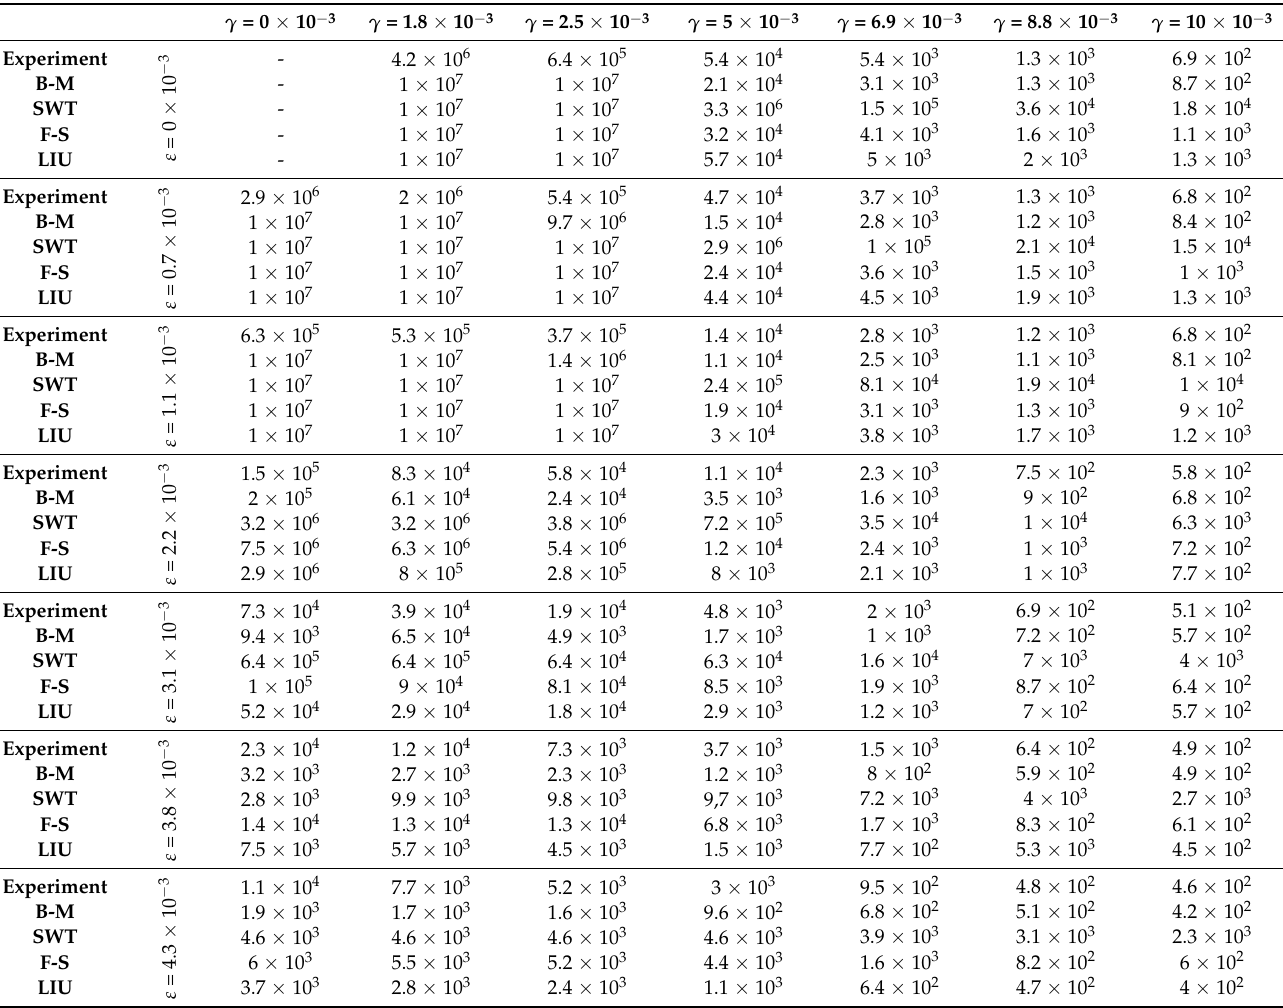
Table 5. Determined average number of cycles to fracture of the frame material at phase shift 90 ◦